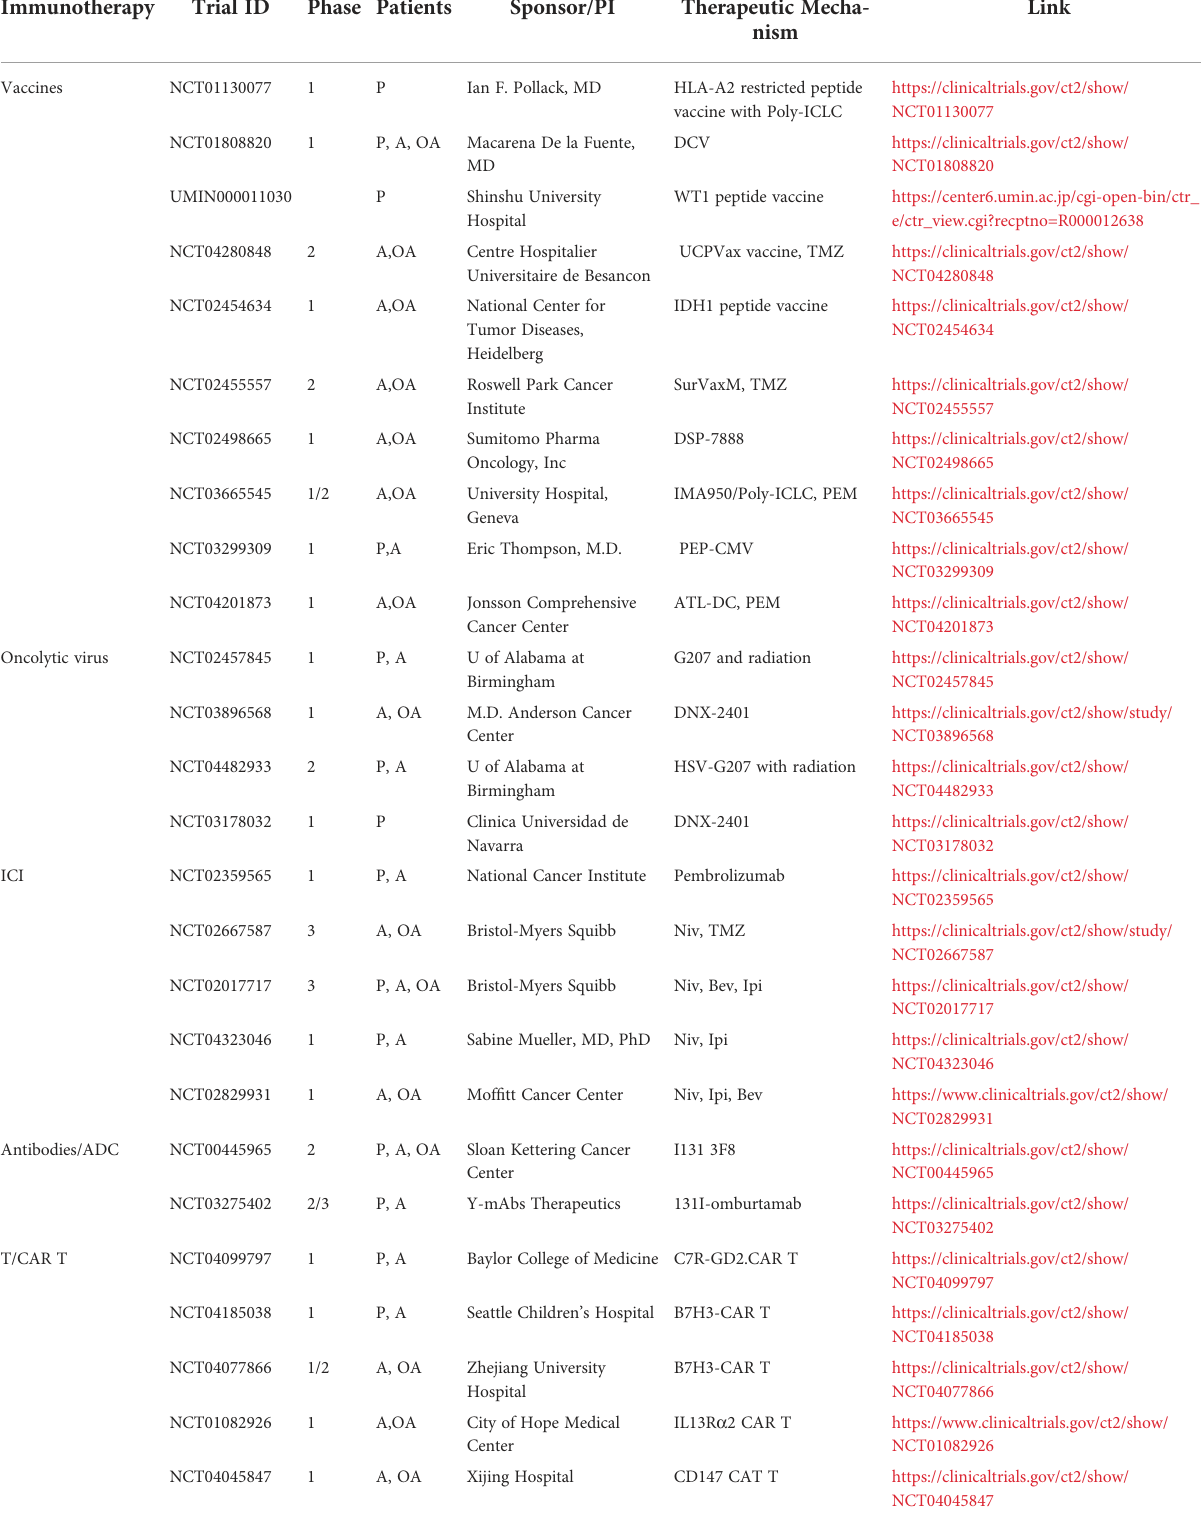
TABLE 2 List of current immunotherapy clinical trials for adult and pediatric high grade gliomas.